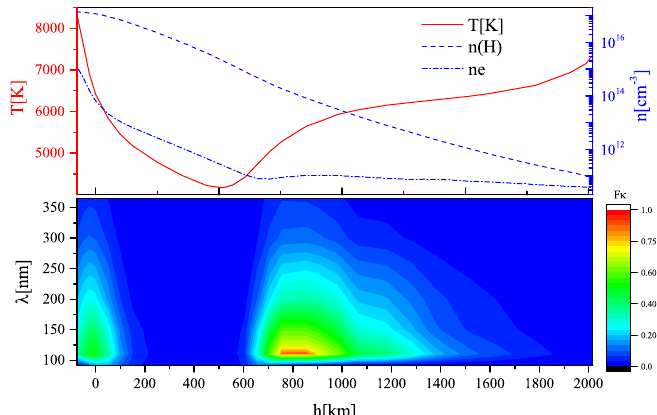
Figure 5. Upper panel: The behavior of the temperature T , N H and Ne as a function of height h within the considered part of the solar atmosphere model; lower panel: A surface plot of the quantity F κ = κ ia / ( κ ea + κ ei ) (data taken from [14]) as a function of λ and height h for a model of the solar photosphere